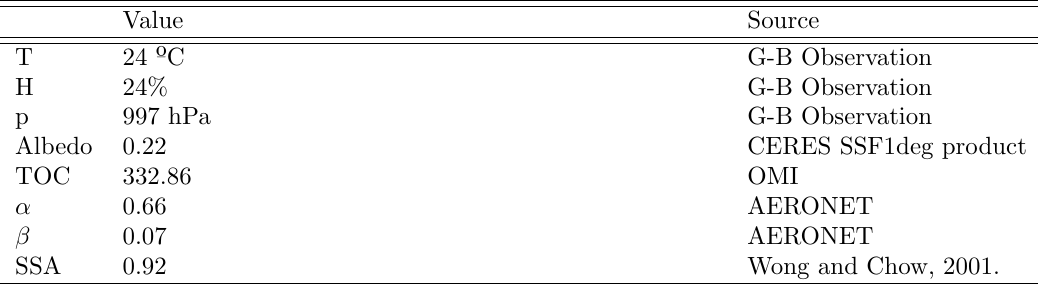
Table 2: Global C Model inputs